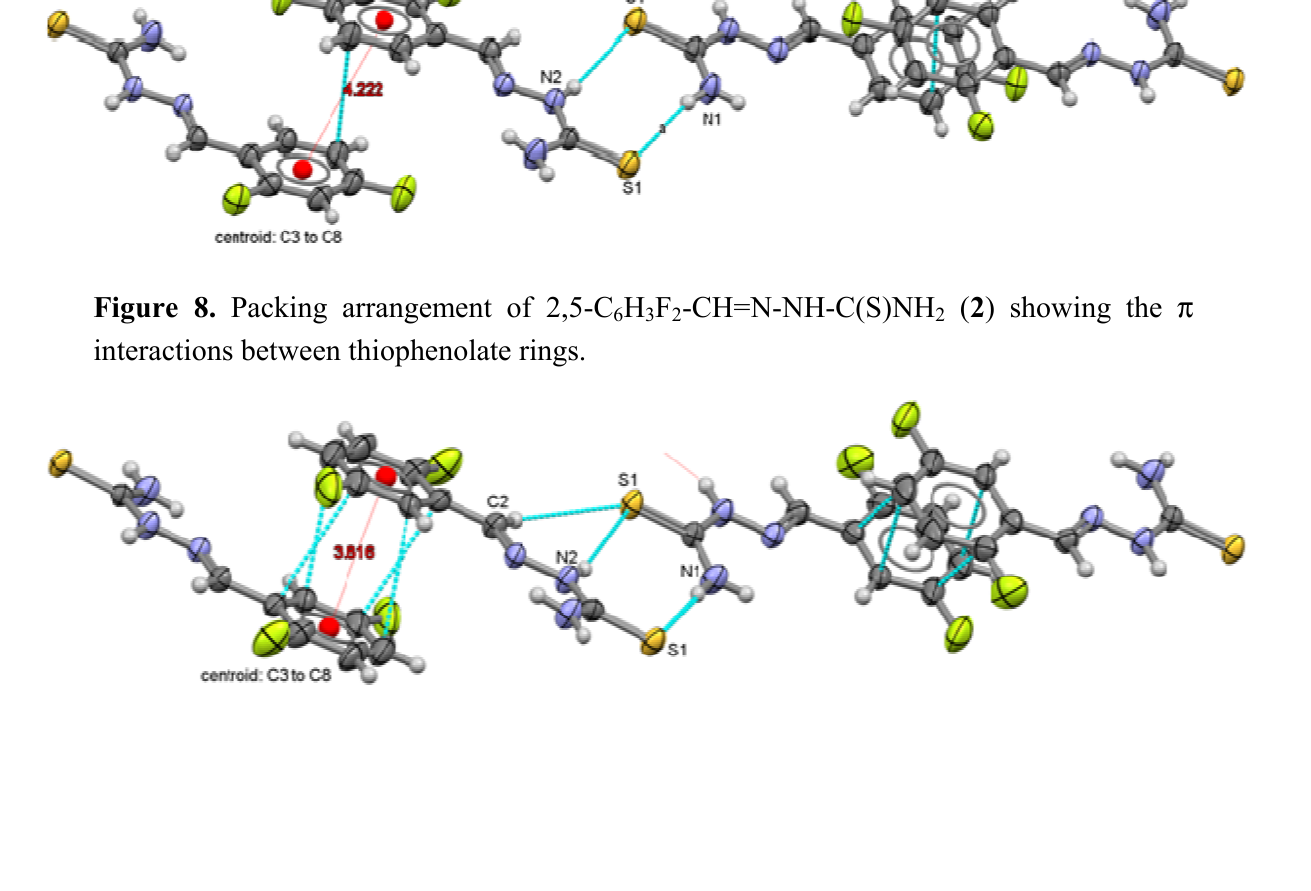
Figure 7. Packing arrangement of 2,4-C interactions between thiophenolate rings.